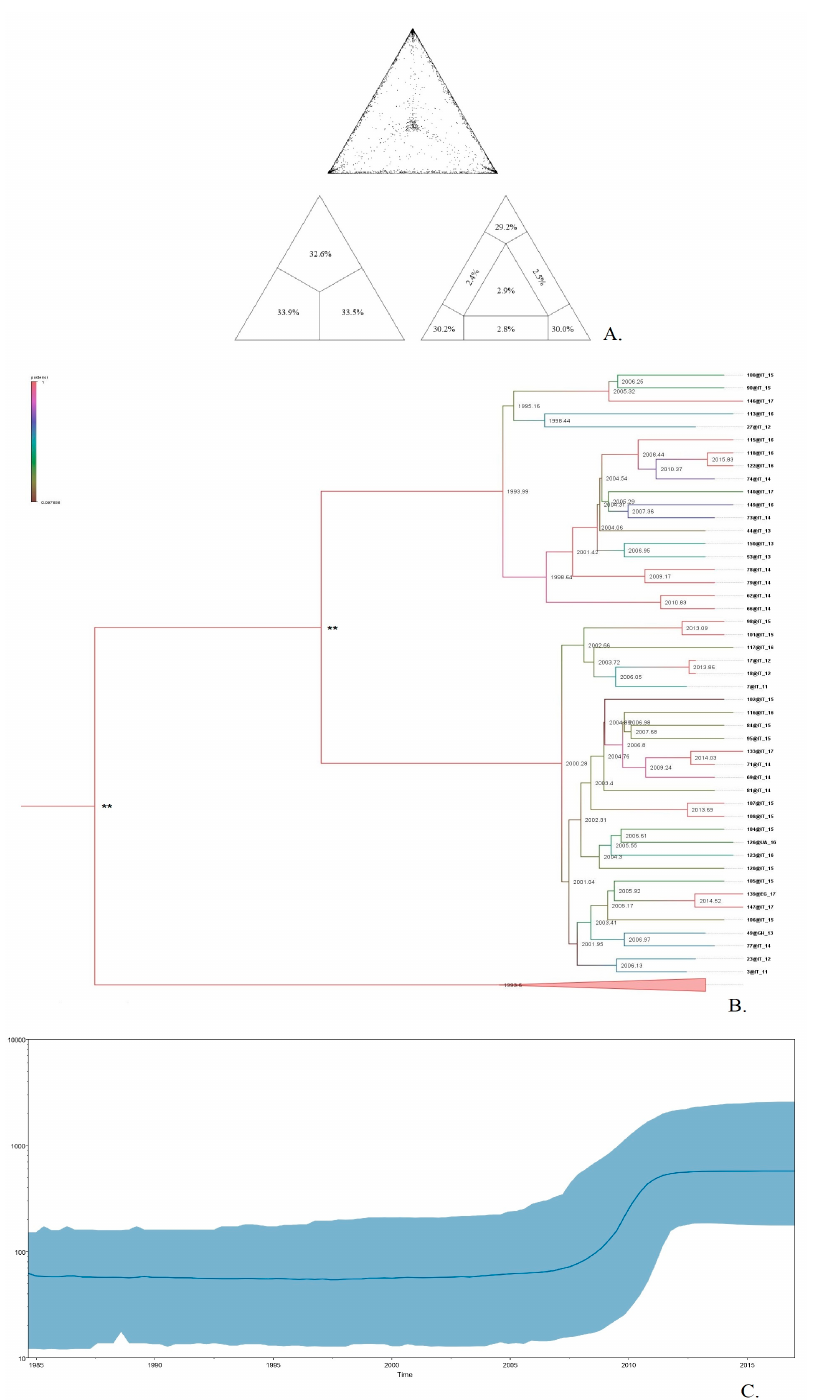
Figure 2. Cluster transmission of CRF02_AG, including Italian heterosexual individuals. The upper part ( A ) shows the Likelihood mapping of the analyzed sequences used for the phylogenetic tree reconstruction, based on 10,000 random quartets. The central triangle is the probability of obtaining a star-type topology. The central part ( B ) represents the consensus tree obtained visualized with FigTree, and the colored branches represent the posteriority, to each node the corresponding node age is associated. The lower part ( C ) represents historical demographic trends in sampled with a Bayesian skyline plot; on the x axis, the date for sampling year is shown; on the y axis the e ff ective population size is